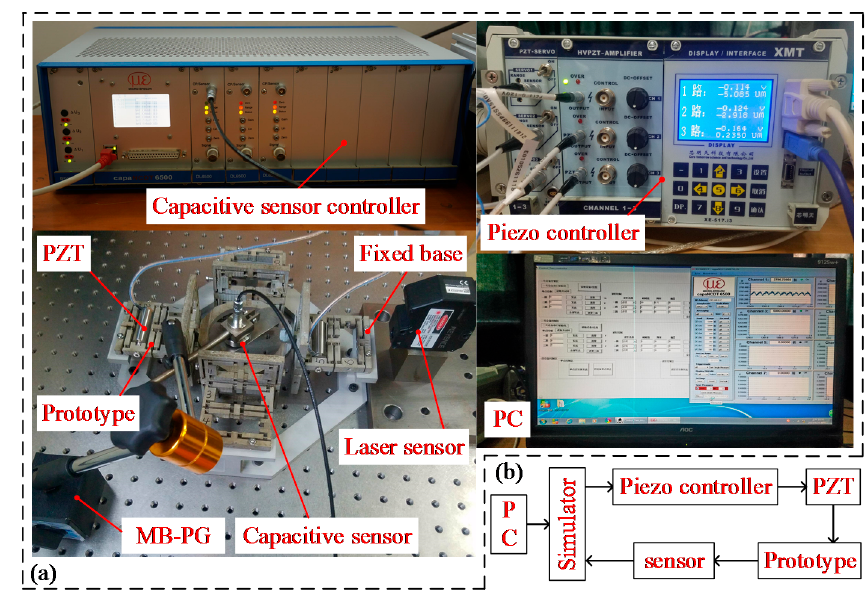
Figure 11. Experimental setup: ( a ) Experiment configuration; ( b ) experimental principle diagram of the compliant platform.